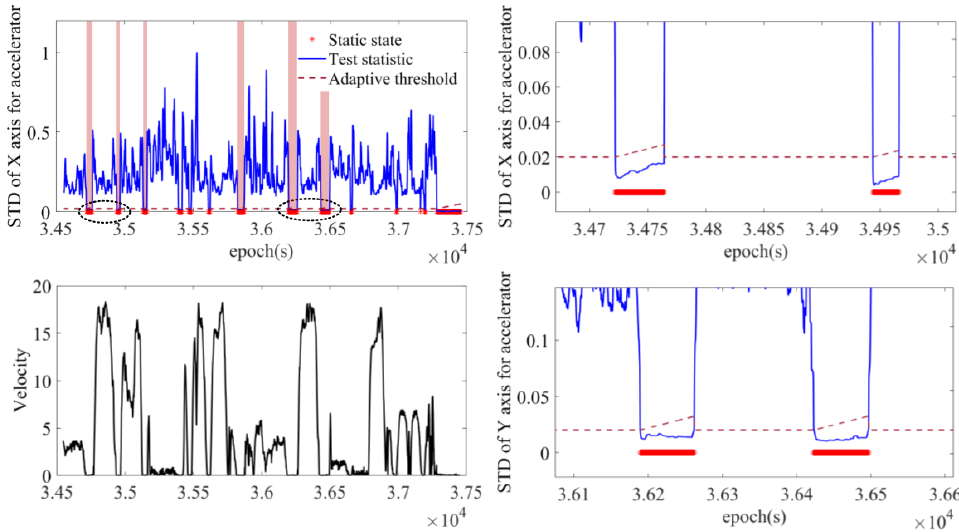
Figure 8. The result of static state detection with adaptive threshold compared with the velocity curve ( left column ) and two detailed figures of static states ( right column ). Two sections are given detailed figures for further analysis (in dashed black circle)